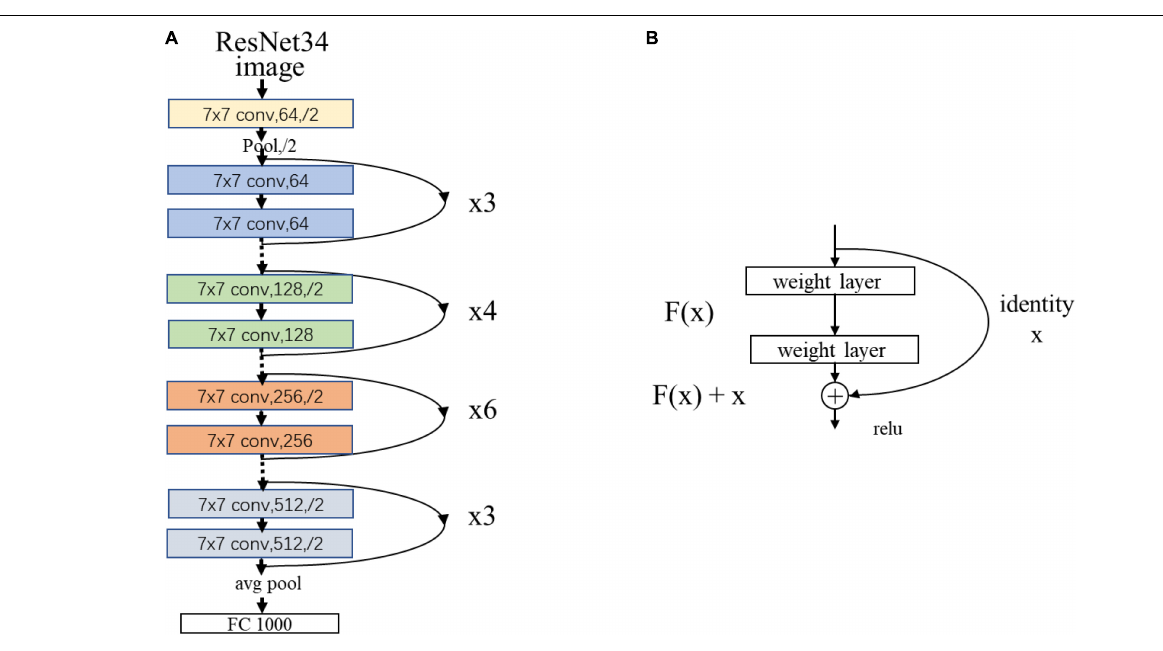
FIGURE 3 | (A) The network structure of the ResNet34 model. “7 × 7” represents the size of the convolution kernel, “conv” represents convolution, “avg pool” represents average pooling, and “fc” represents fully connected layer. “64” means the number of channels, and “/2” means stride of 2. (B) Residual learning: a building block. x represents direct identity mapping, F(x) represents residual mapping, and F(x)+x is